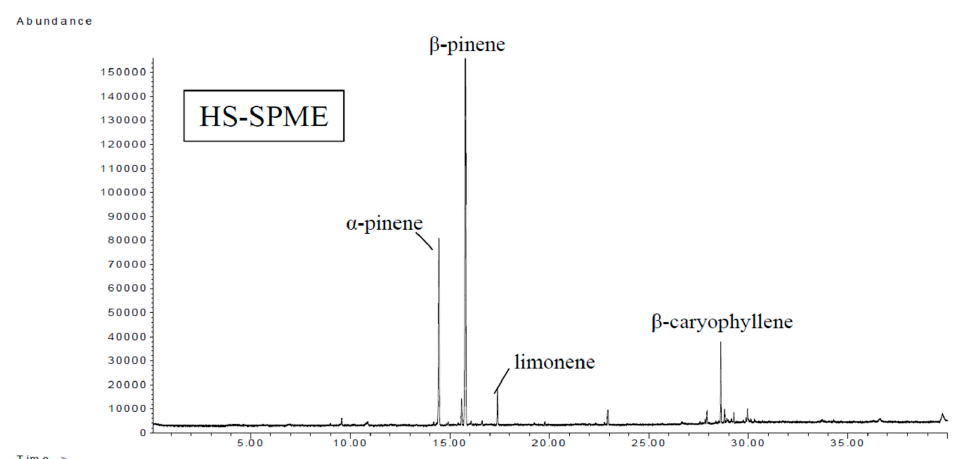
Foods 2019 , 8 , x FOR PEER REVIEW Figure 4. Total ion chromatogram of volatile components of Nongshi No. 1 determined using HS-SPME.